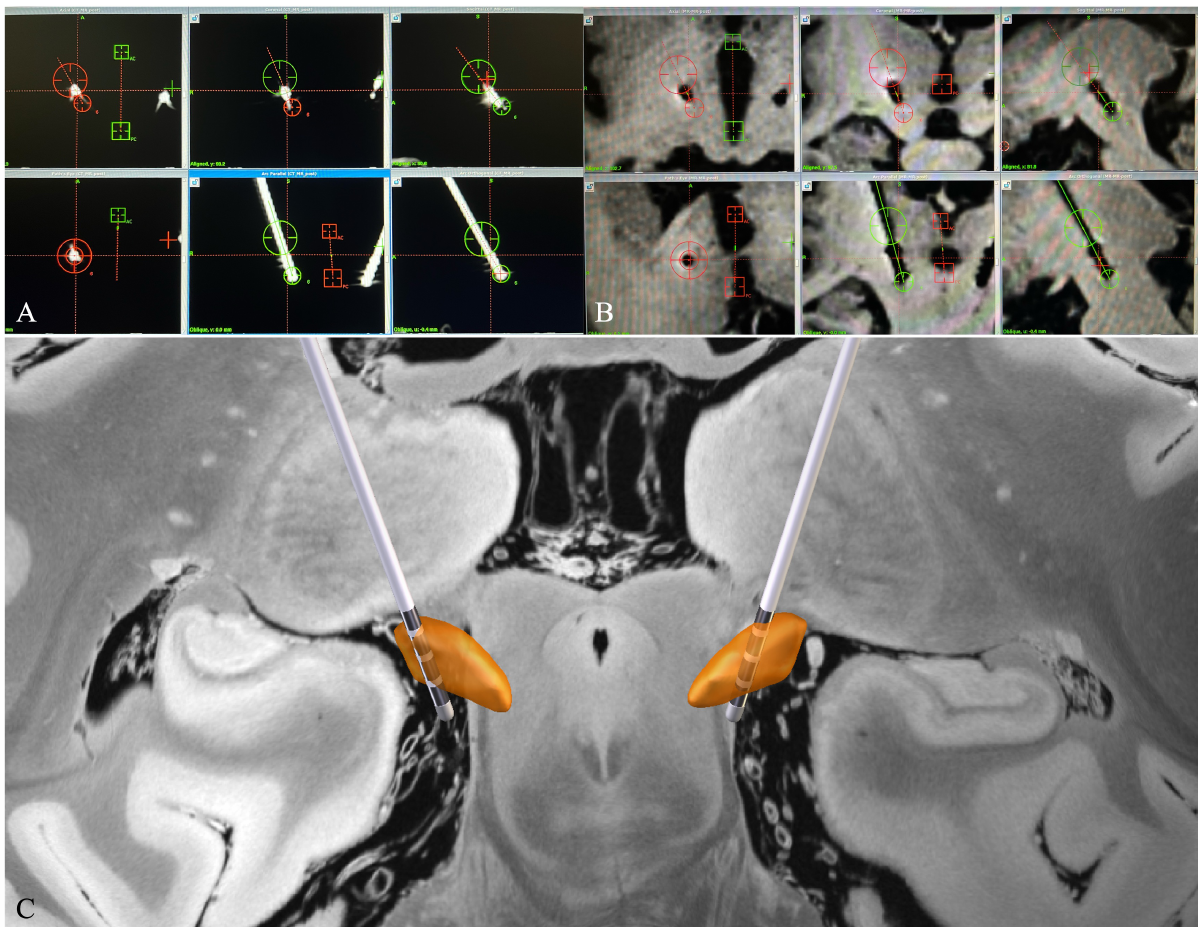
Figure 1. DBS electrode reconstruction using Surgiplan and Lead-DBS. Reconstruction of the DBS electrode in an example patient using Surgiplan with postoperative CT ( A ), Surgiplan with postopera- tive MRI ( B ), and Lead-DBS toolbox ( C ). In postoperative CT and MRI, the electrode is represented by a signal with a different intensity; in postoperative CT, the electrode is represented by a hyperintense electrode artifact ( A ), whereas in postoperative MRI, the electrode is estimated as an imaginary center of the hypointense signal ( B